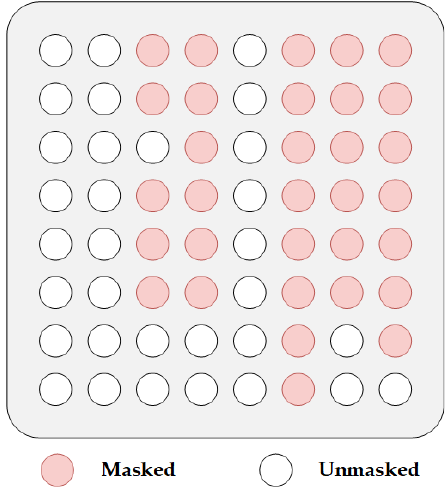
Figure 3. An example of perm_mask matrix.